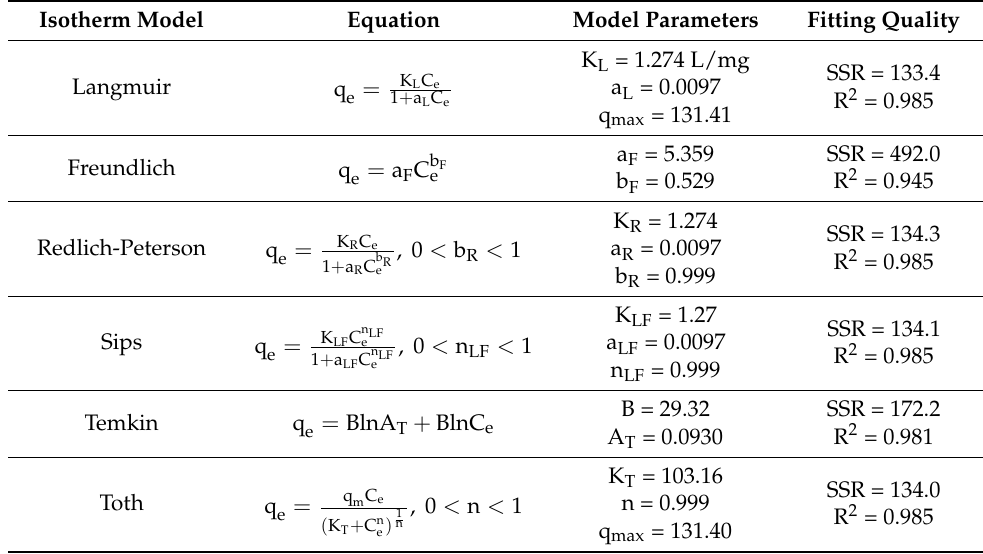
Table 2. Parameters of the different isotherm models.